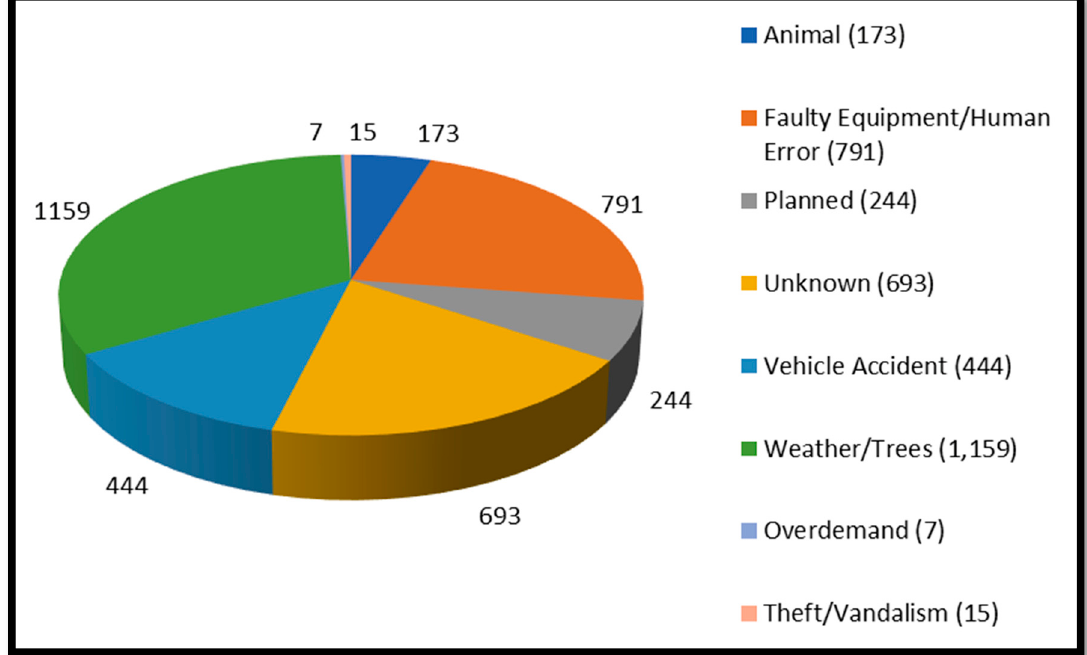
Figure 2. U.S. reported power outages by cause in 2017. Source: Eaton’s Blackout Tracker [16].